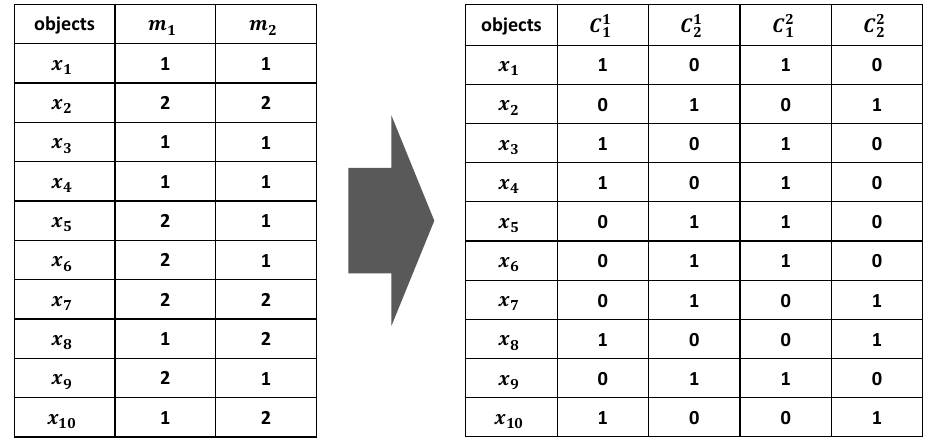
Figure 10. An illustrative example of two clustering members for a dataset with 10 objects.